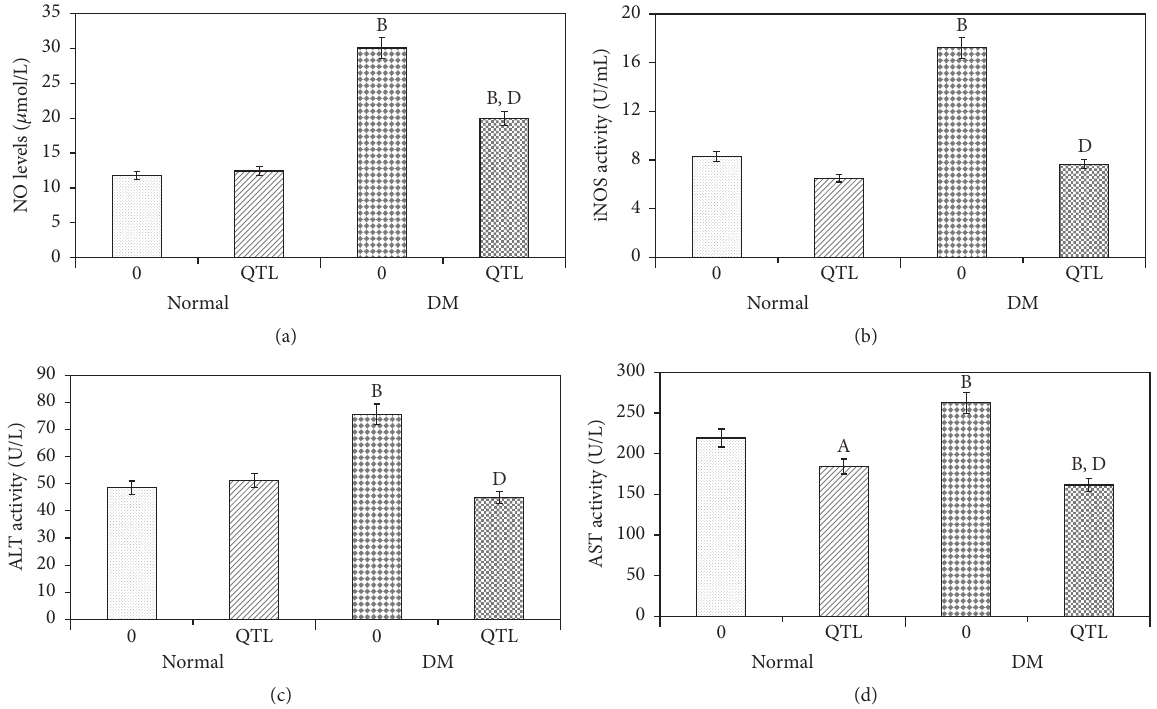
Figure 2: Effects of QTL on oxidative stress and hepatic function markers in serum of normal and diabetic mice . NO level (a); iNOS activity (b); ALT activity (c); and AST activity (d). Data represent the mean ± SD from ten animals in each group. A 𝑃 < 0.05 compared to control group; B 𝑃 < 0.01 compared to control group; C 𝑃 < 0.05 compared to diabetic group; D 𝑃 < 0.01 compared to diabetic